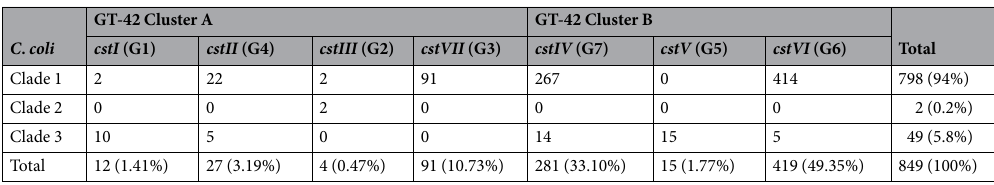
Table 2. Distribution of GT-42 genes among C. coli